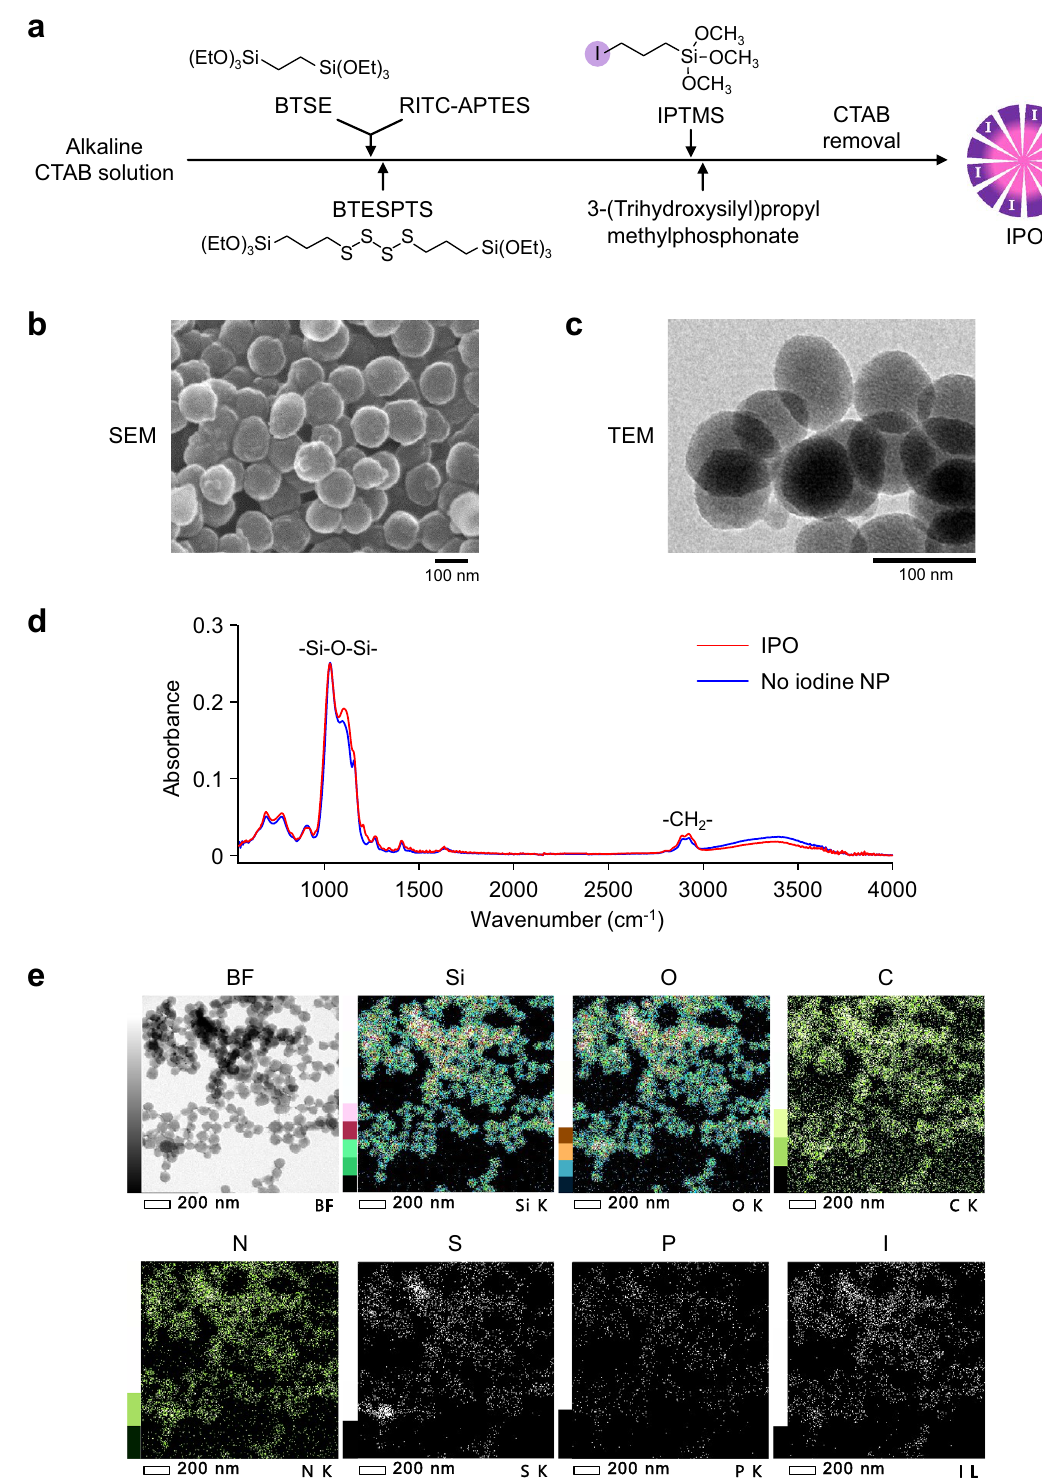
Figure 1. Synthesis and electron microscopy images of IPO nanoparticles. ( a ) Synthetic scheme of IPO. BTESPTS, bis[3-(triethoxysilyl)propyl]tetrasulfide; BTSE, 1,2-bis(triethoxysilyl)ethane; IPTMS, (3-iodopropyl) trimethoxysilane. SEM ( b ) and TEM ( c ) of IPO. ( d ) FT-IR analysis of IPO. ( e ) STEM-EDX with elemental mapping of Si, O, C, N, S, P and I of IPO. BF bright